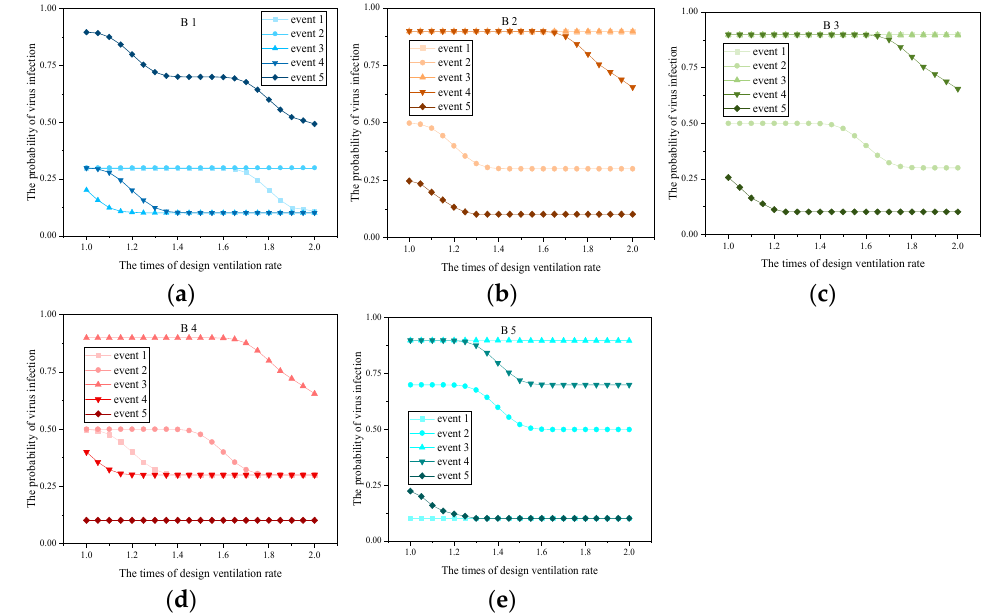
Figure 7. Influence of the building ventilation intervention on the risk of virus infection. ( a ) Dormitory, ( b ) Lecture building, ( c ) Office building, ( d ) Canteen building, ( e ) Library building. (2) Influence of restricting occupancy on the probability of virus infection.